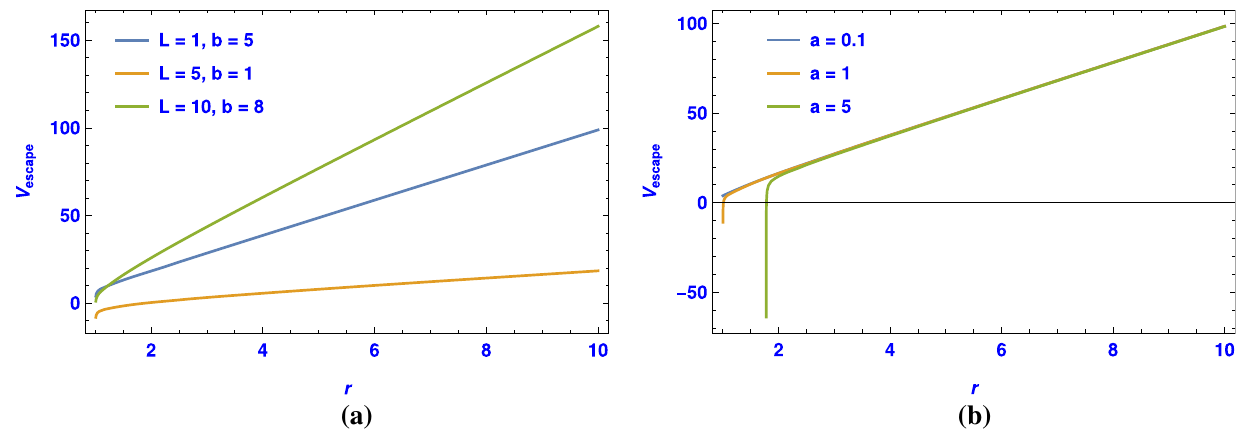
escape velocity against r for different value of DE parameter a . So, the DE effects the trajectories of the particles only near the horizon shown